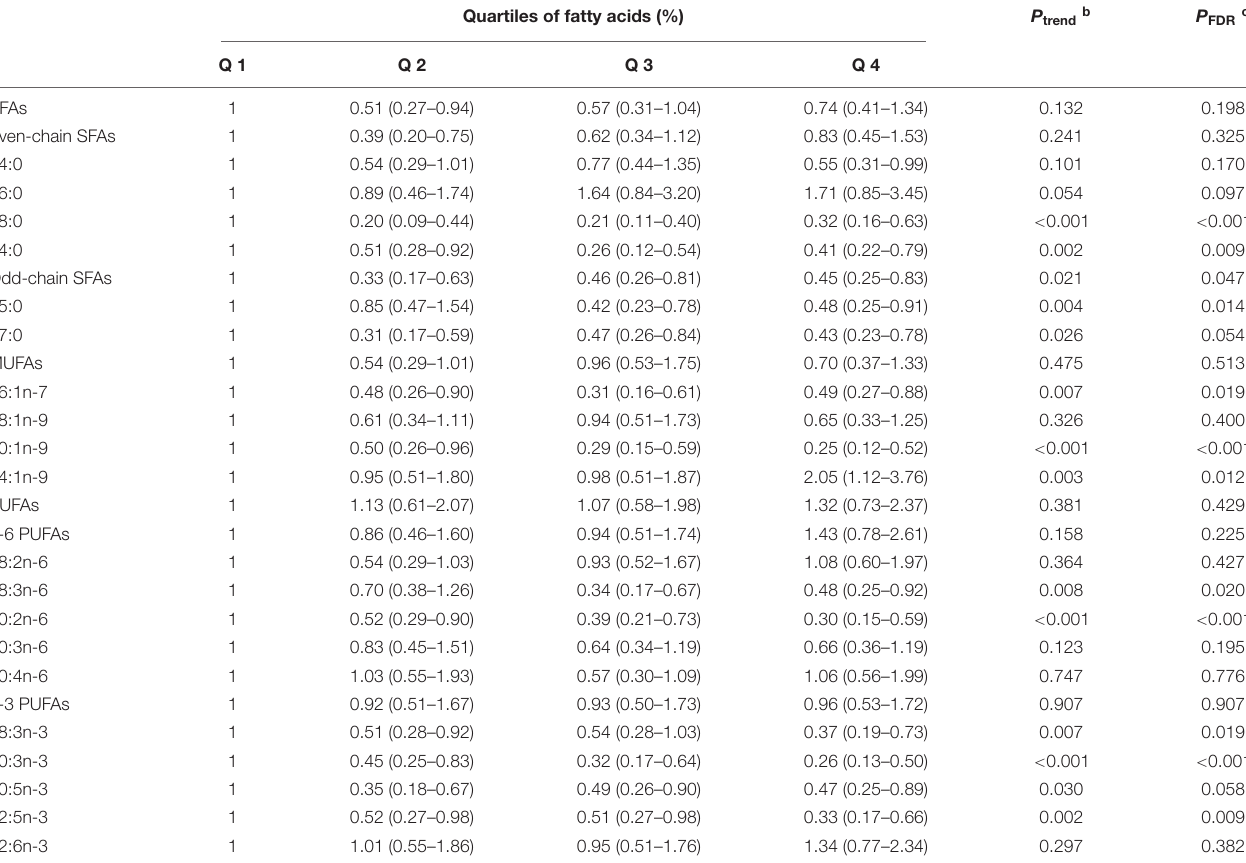
a Values are ORs (95% CIs). Adjustments were made for age, gestational age at blood collection, parity, prepregnancy BMI, family history of diabetes, smoking, and alcohol use. b P trend values were obtained from logistic regression by treating median value of each quartile of individual fatty acids as continuous variables. c P FDR values were P values of FDR corrections for multiple comparisons of fatty acids. FDR, False discovery rate; GDM, gestational diabetes mellitus; MUFAs, monounsaturated fatty acids; PUFAs, polyunsaturated fatty acids; SFAs, saturated fatty